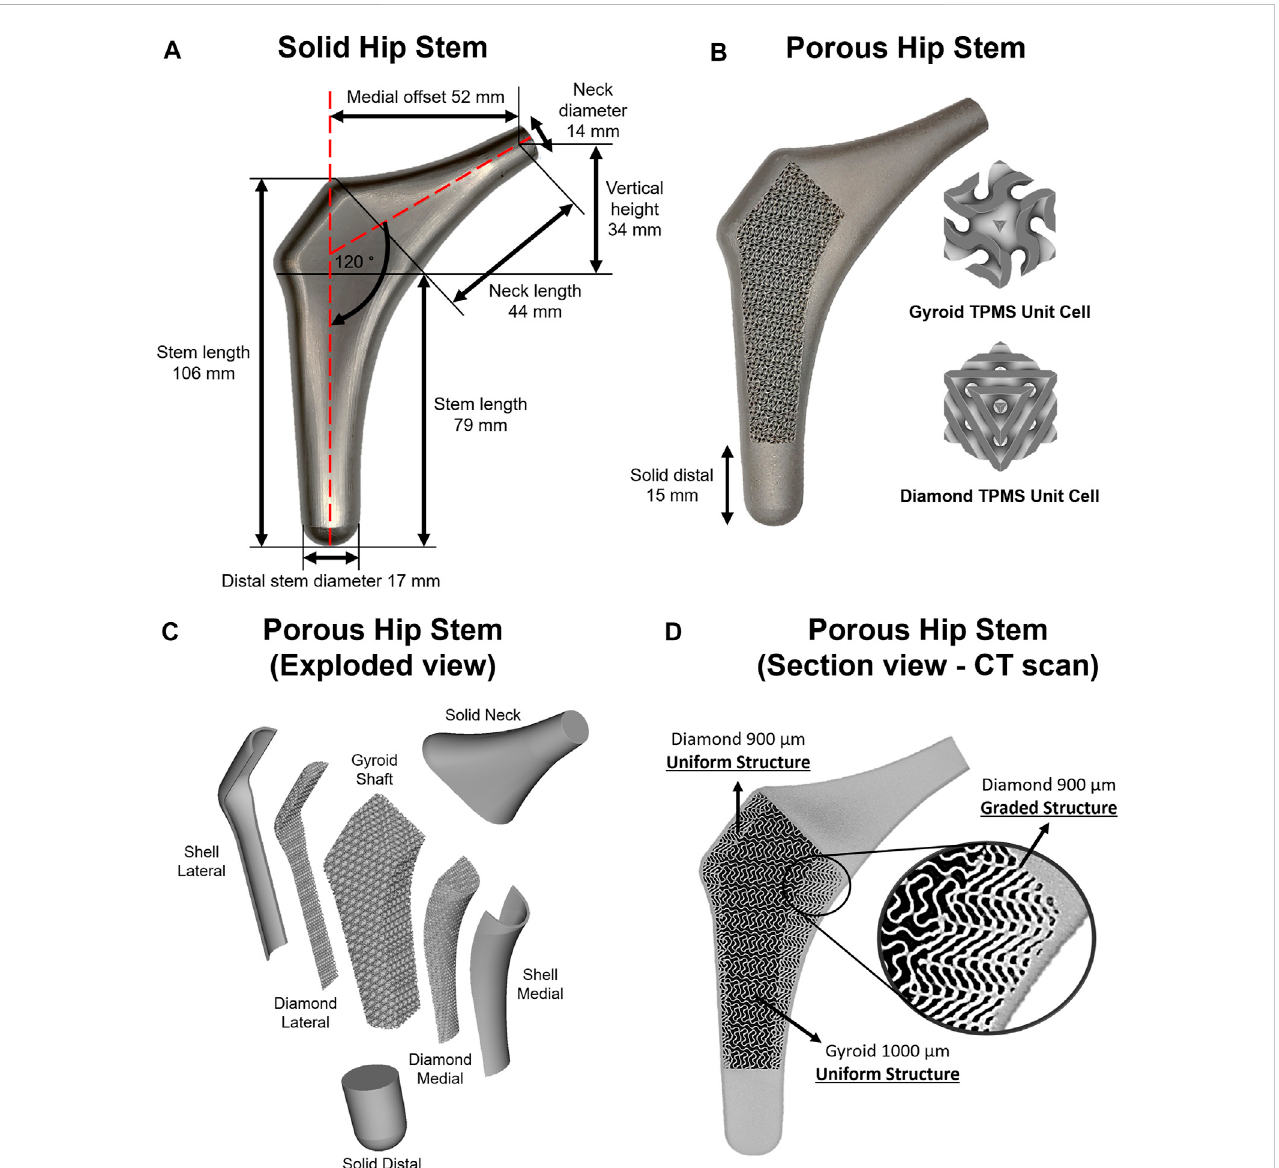
FIGURE 2 (A) Solid hipstem design and dimensions. (B) 3D printed porous hipstem with gyroid and diamond TPMS unitcells implemented. (C) Isometricexploded view of the porous hip stem. (D) Micro CT sectional view of the porous hip stem with functionally graded diamond structures within medial section.